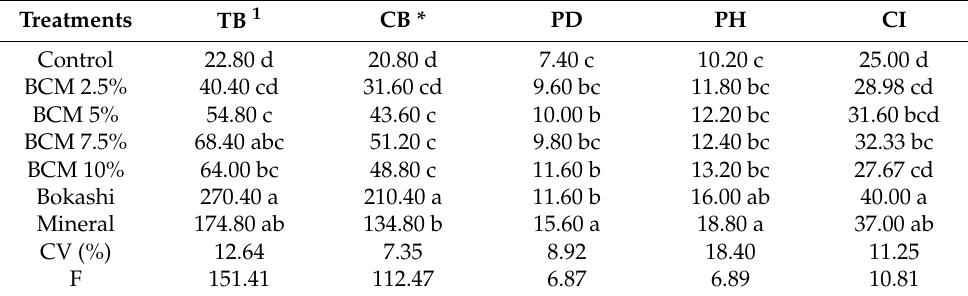
Table 3. Means of total biomass (TB) (g), commercial biomass (CB) (g), plant diameter (PD) (cm), plant height (PH) (cm), and chlorophyll index (CI) (Falker index) in radicchio chicory Palla Rossa cv. submitted to different concentrations of boiled chicken manure (BCM), bokashi, and mineral fertilization in a greenhouse. Londrina, Paran á State, Brazil, 2020.